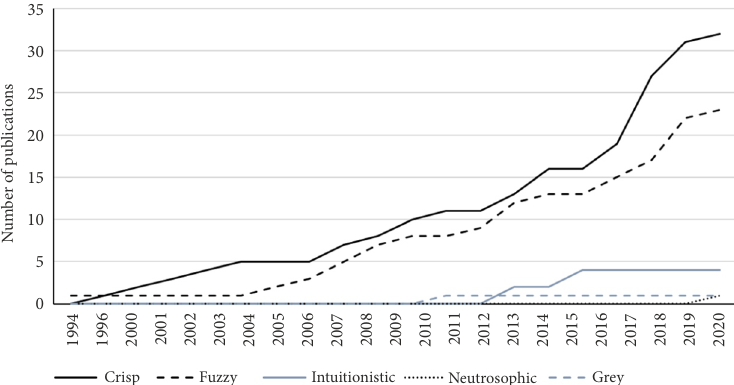
Figure 10. Distribution over time of the mathematical logic used to model subjectivity in sustainable decision-making related to bridge